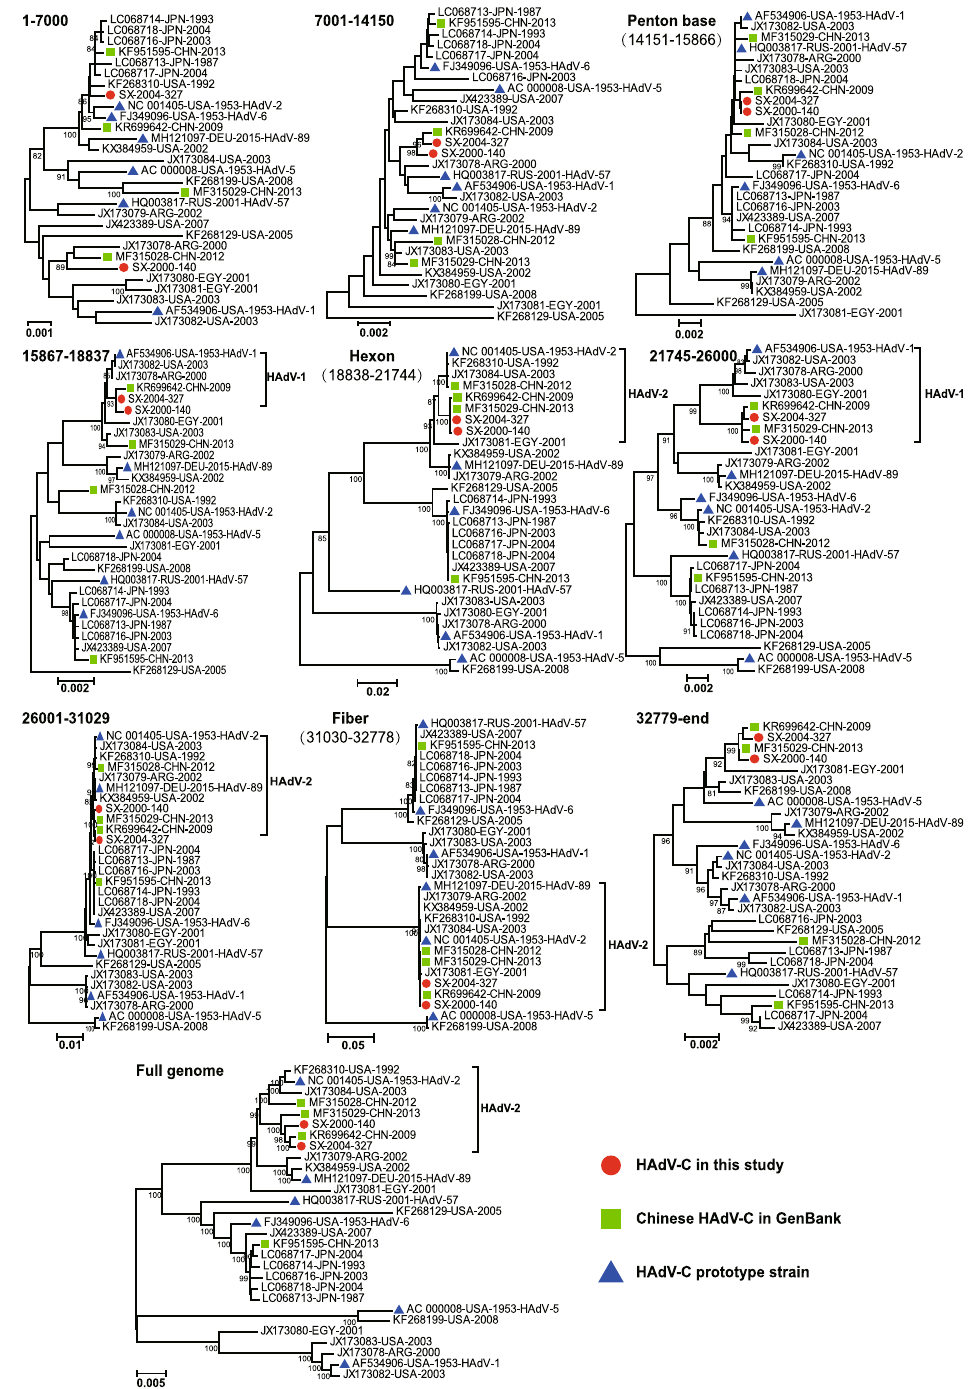
Figure 1. Neighbor-joining phylogenetic tree based on WGS of 29 HAdV-C strains. The nine genomic regions were used to generate the trees based on the reference HAdV-2 prototype strain (GenBank accession number NC_001405). Only bootstrap values greater than 80% are displayed, which indicate the strong